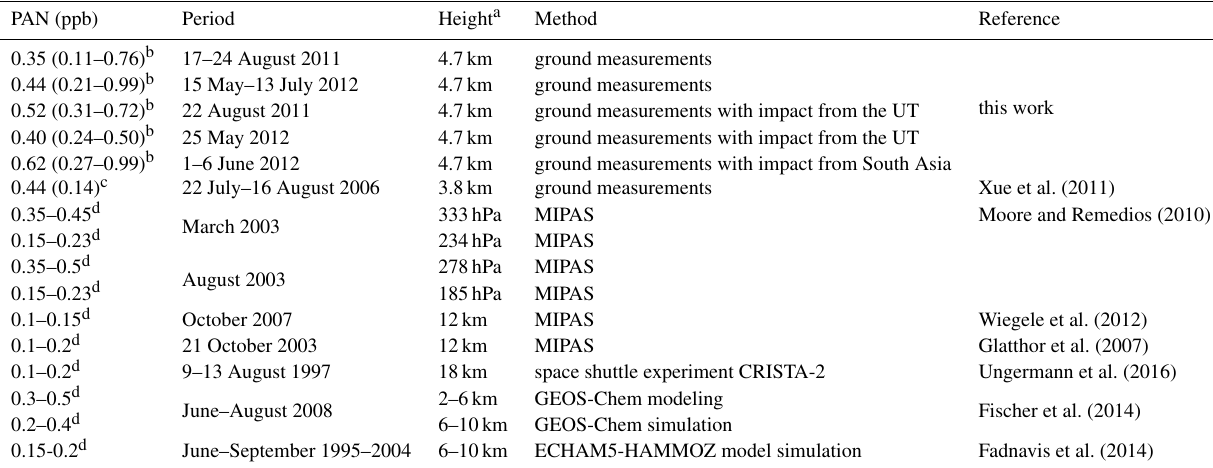
Table 1. Measured and modeled PAN at different heights over the TP. PAN